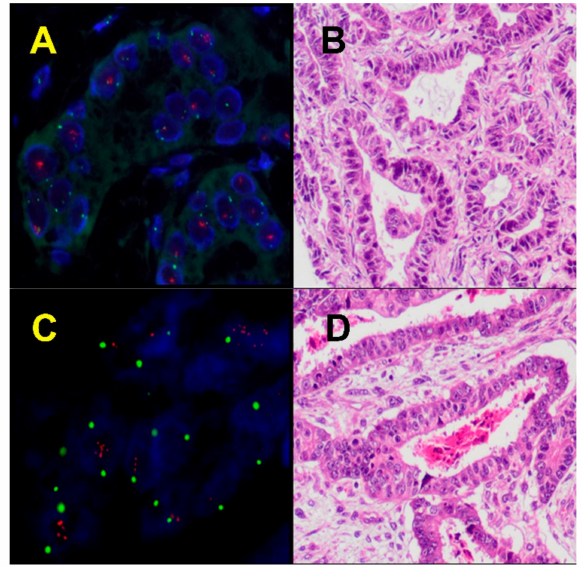
Figure 3. Amplification of oncogenes in endometrial carcinosarcomas analyzed by fluorescence in situ hybridization (FISH) ( A ) and ( B ), MYC proto-oncogene, bHLH transcription factor ( MYC ) amplification ( C ), and ( D ) Cyclin D1 ( CCND1 ) amplification. Original magnification × 100 for A and C, and × 20 for